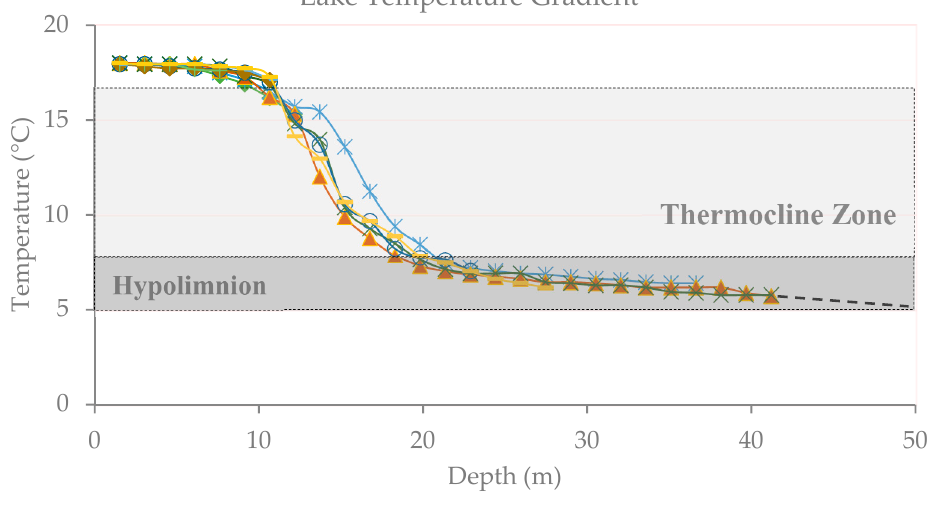
Figure 6. Lake temperature profile.